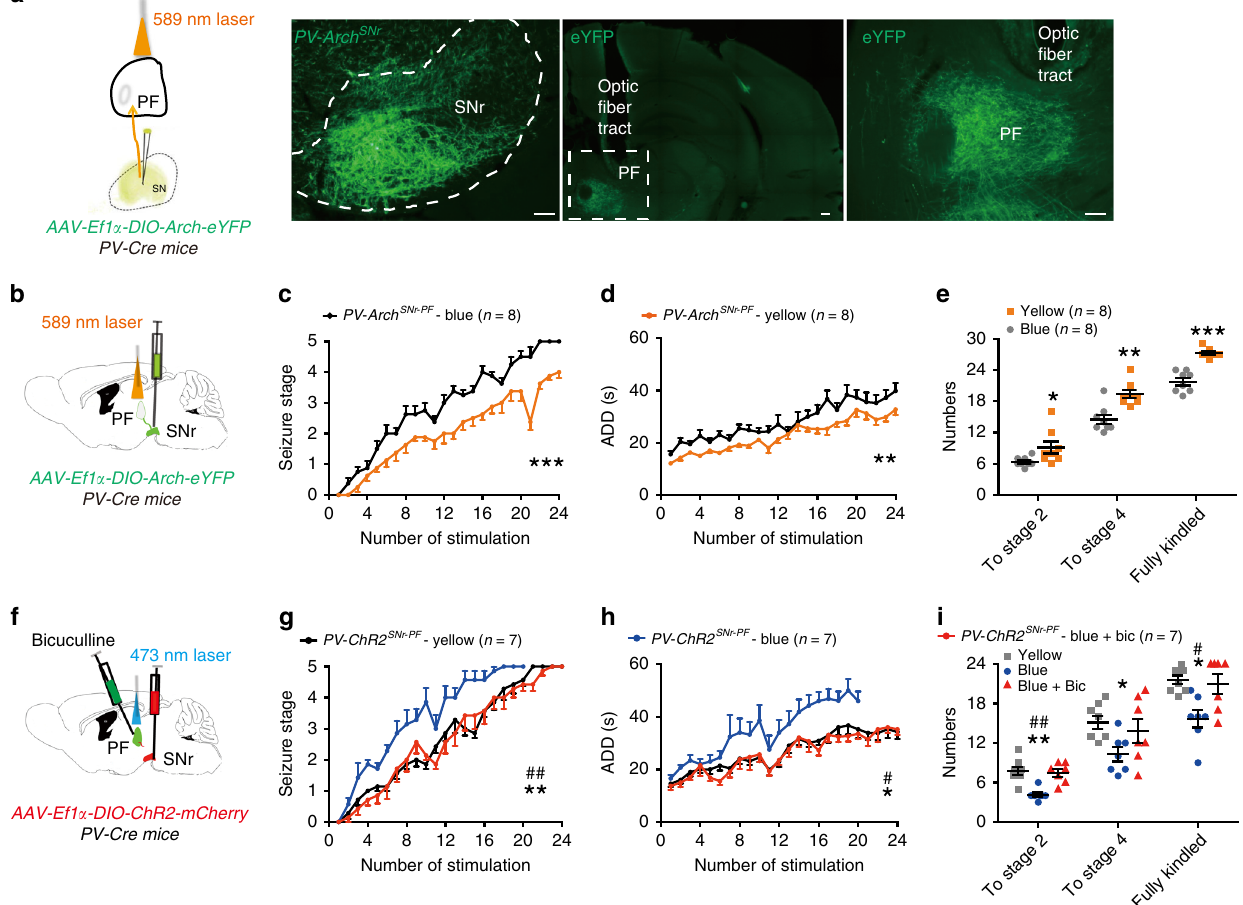
Fig. 4 SNr-PF PV projections are involved in kindling progression. a Representative images showing the expression of Arch-GFP soma in the SNr and Arch-GFP axon fi bers within the PF from a PV-Arch SNr mouse. Scale bar, 50 μ m. b Scheme of experiment for optogenetic inhibition of the SNr-PF